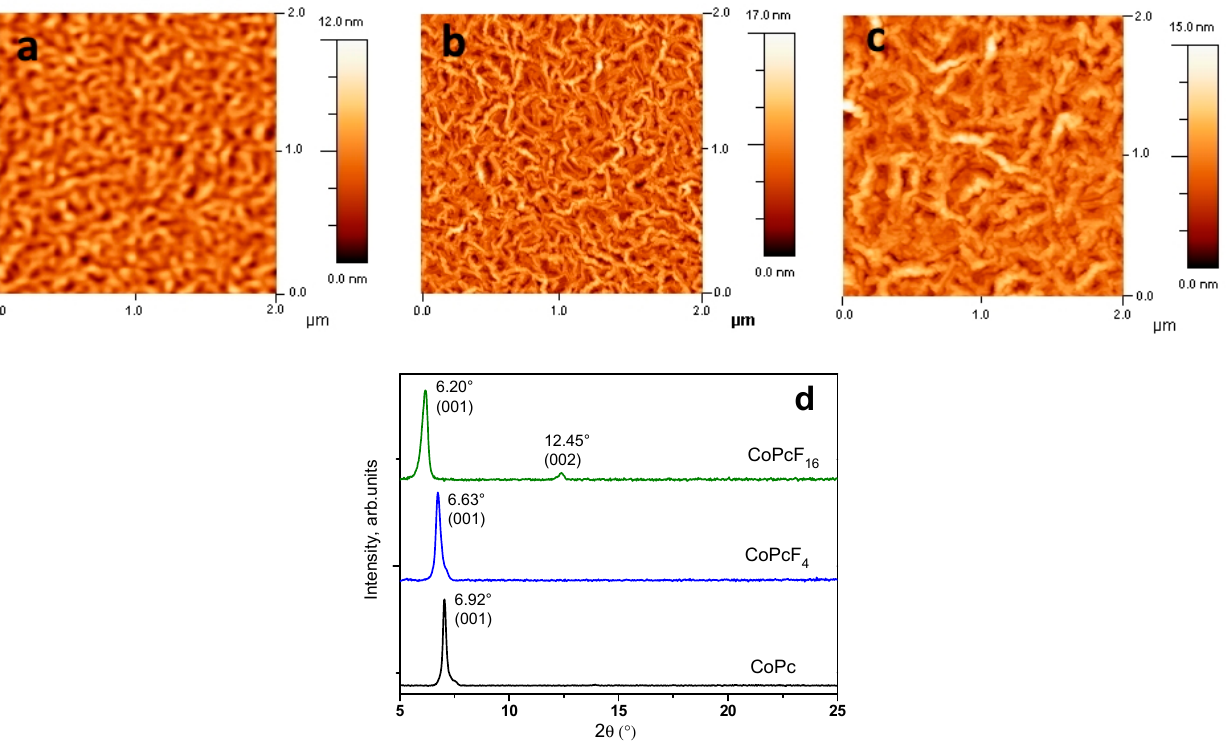
Figure 1. Topographic AFM images (2 µ m × 2 µ m) of CoPcF 16 thin films grown at different elevated substrate temperatures: 100 ◦ C ( a ), 220 ◦ C ( b ), and 290 ◦ C ( c ). Adapted from [37] with permission from Elsevier. XRD patterns of CoPcF x (x = 0, 4, 16) thin films ( d ).